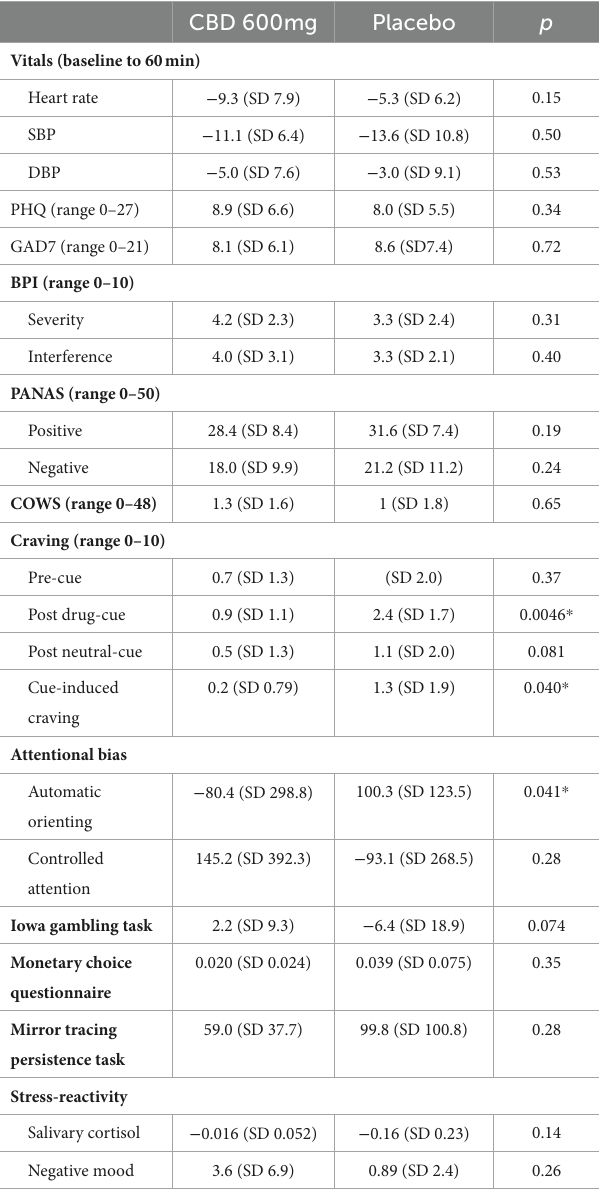
TABLE 2 Summary of reward- and stress-related neurocognitive findings ( n =